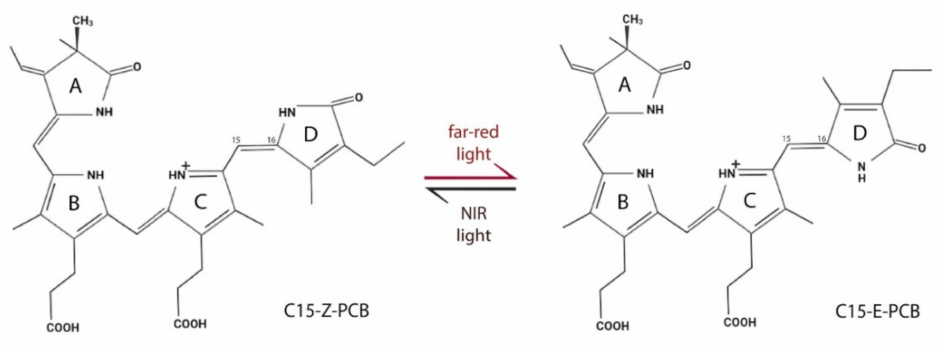
Figure 3. Light-driven changes in structure of tetrapyrrole chromophore PCB. Reversible Z/E isomerization of the C15/C16 double bond in bound PCB chromophore under illumination with far-red (640–680 nm) and NIR light (740–780